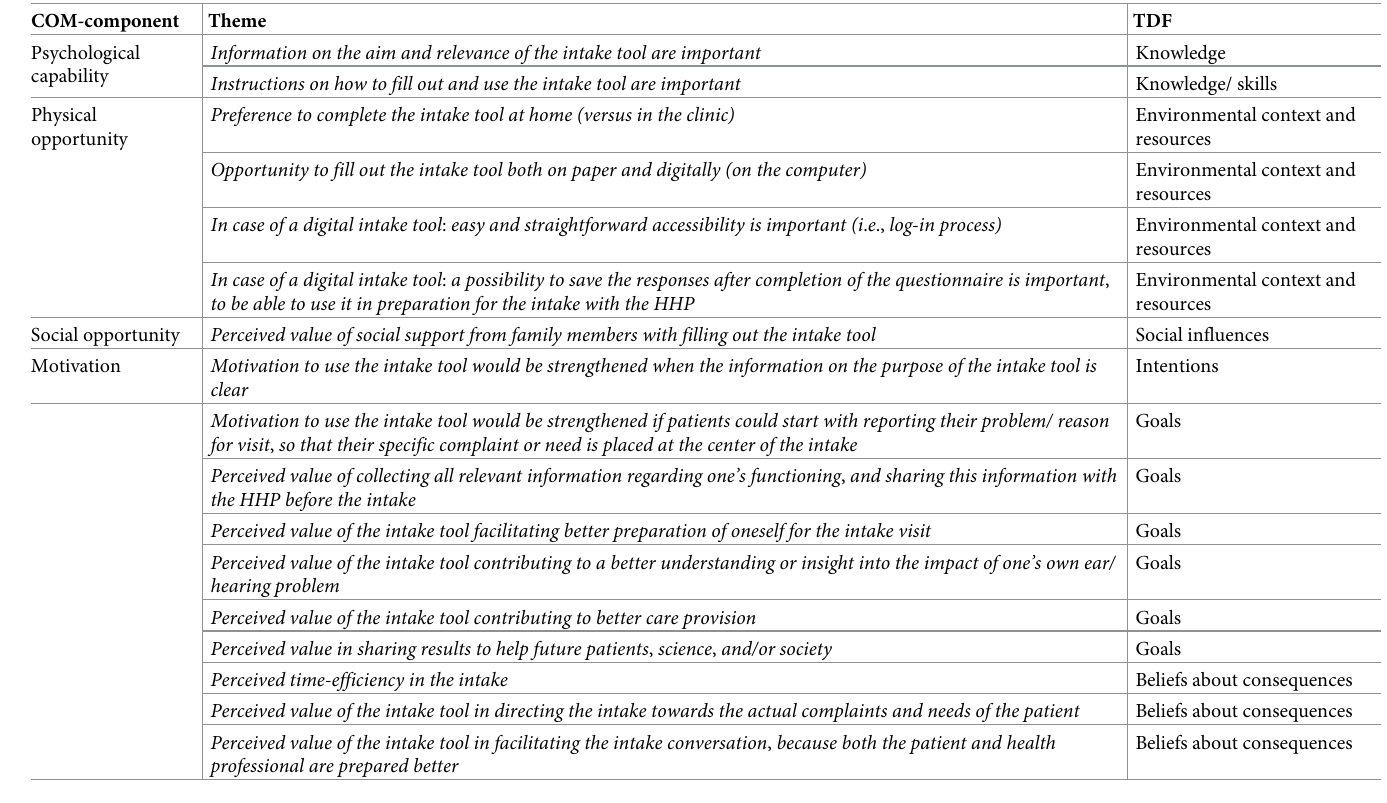
Table 6. Identified enablers of the use of the ICF-based intake tool as perceived by patients.